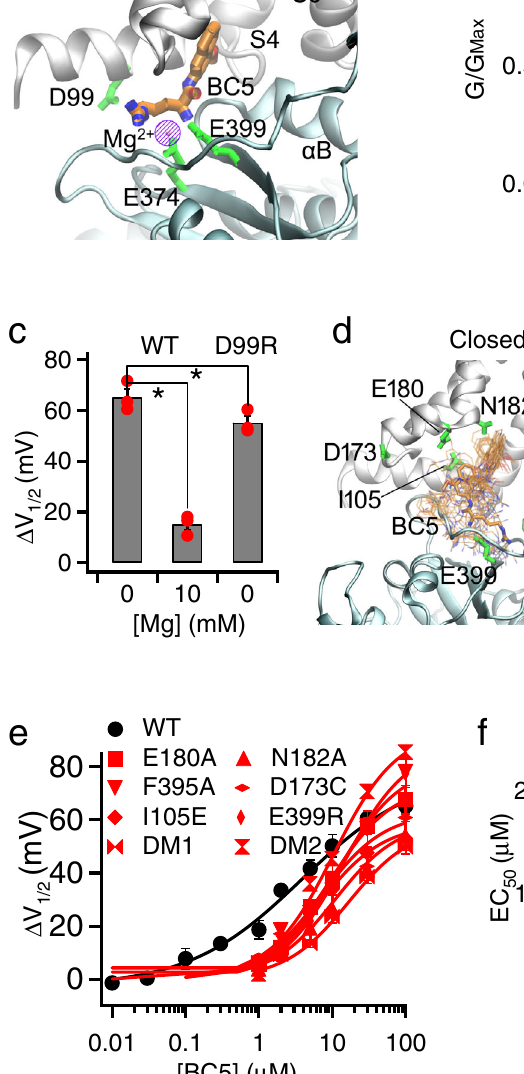
in solid circles. d Dynamic interactions of BC5 in the binding pocket of metal-free (left) and Ca 2+ -bound (right) BK channels. Snapshots of BC5 (thin sticks) were BC5. n =3 – 12,exactnforeachdatapointisshowninthe “ Reproducibility ” sectionin “ Methods. ” TheWTcurveistakenfromFig.1e. f MaximalG-Vshift( 4 V max 1 = 2 )andEC 50 ofBC5formutationsandtheWT.DM1:doublemutationE180A/N182A;DM2:I105E/ E399R.Thedatawereobtainedfrom fi ttingsofthedoseresponseinFig.2eusingHill equation. The standard errors of EC 50 and 4 V max 1 = 2 were estimated directly from the SEMs of the input data and validated by numerical